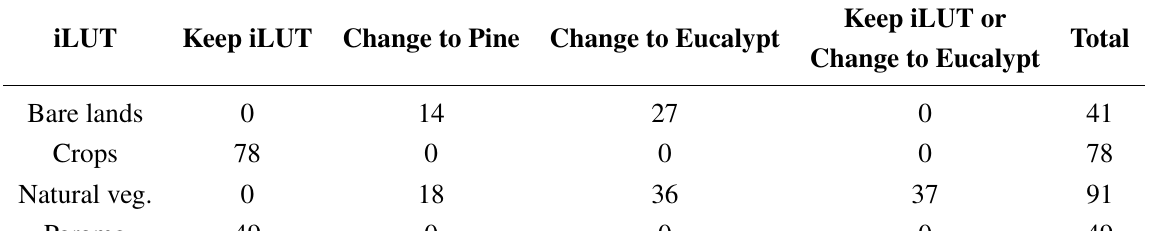
Table 2. Land use types distribution resulting from the application of the iterative ideal point thresholding method. iLUT, initial LUT.